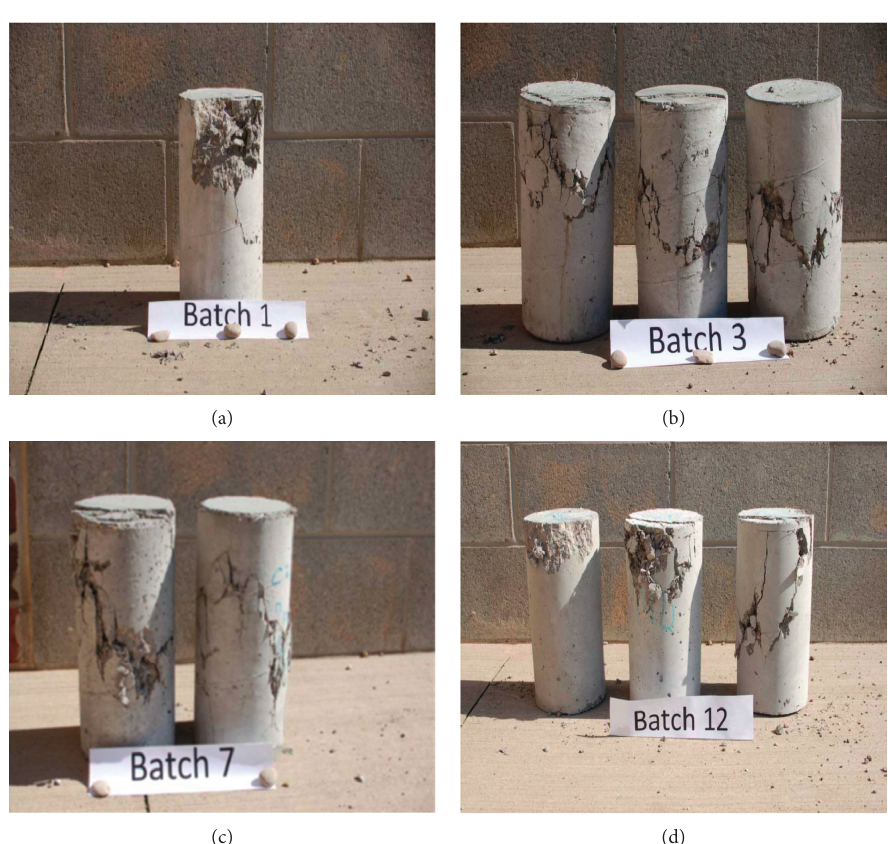
Figure 1: Compression failure of specimens from four batches. (a) Batch 1. (b) Batch 3. (c) Batch 7. (d) Batch 12.